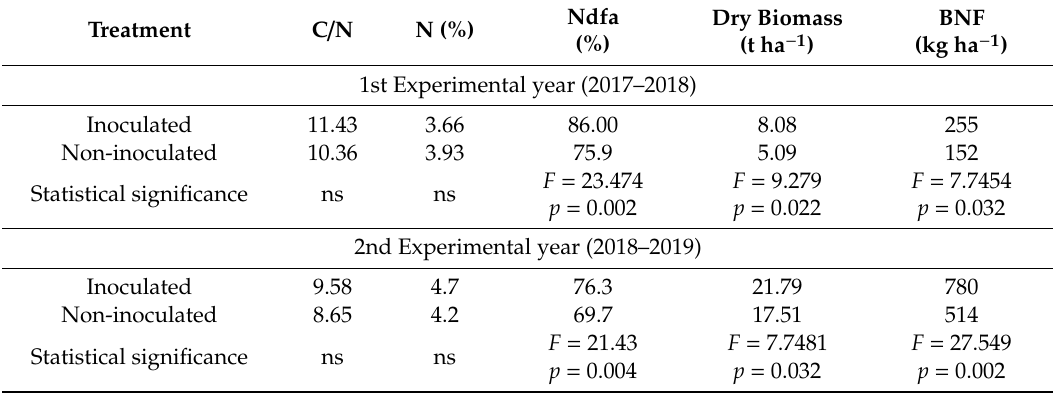
Table 5. Impact of faba bean inoculation with Rhizobium laguerreae VFLE1 on the C / N ratio, N concentration (%), %Ndfa, dry biomass (t ha − 1 ), and amount of biologically fixed N (BNF, kg ha − 1 ) in the aboveground plant biomass, in both experimental